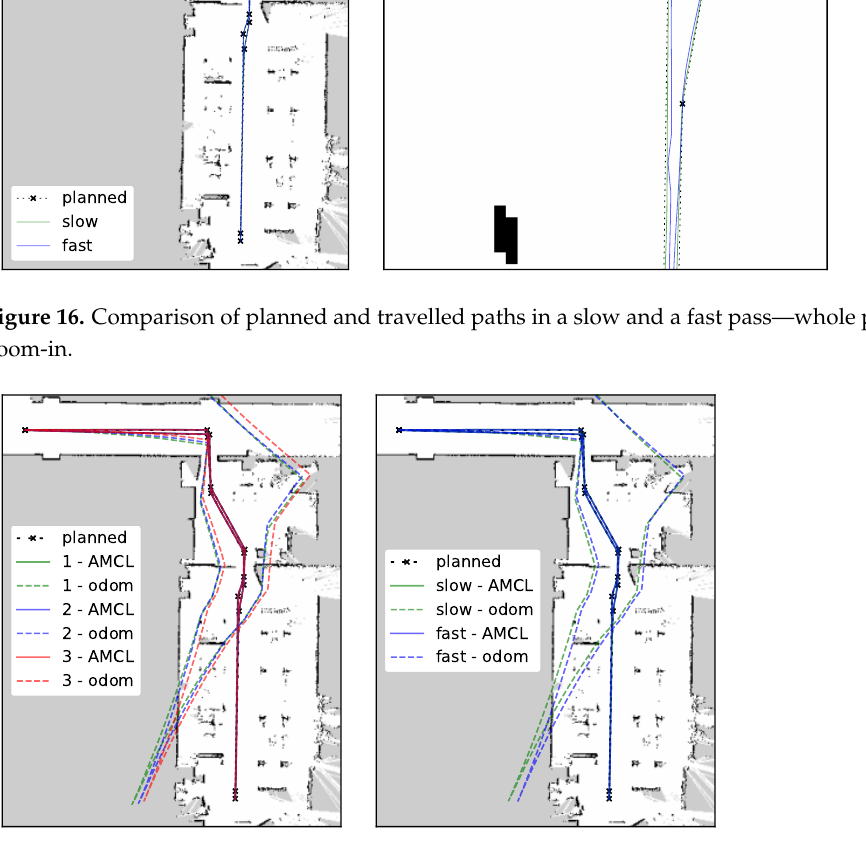
Figure 17. Comparison of localization from AMCL and odometry—passes 1 to 3 ( left ) and fast vs. slow ( right